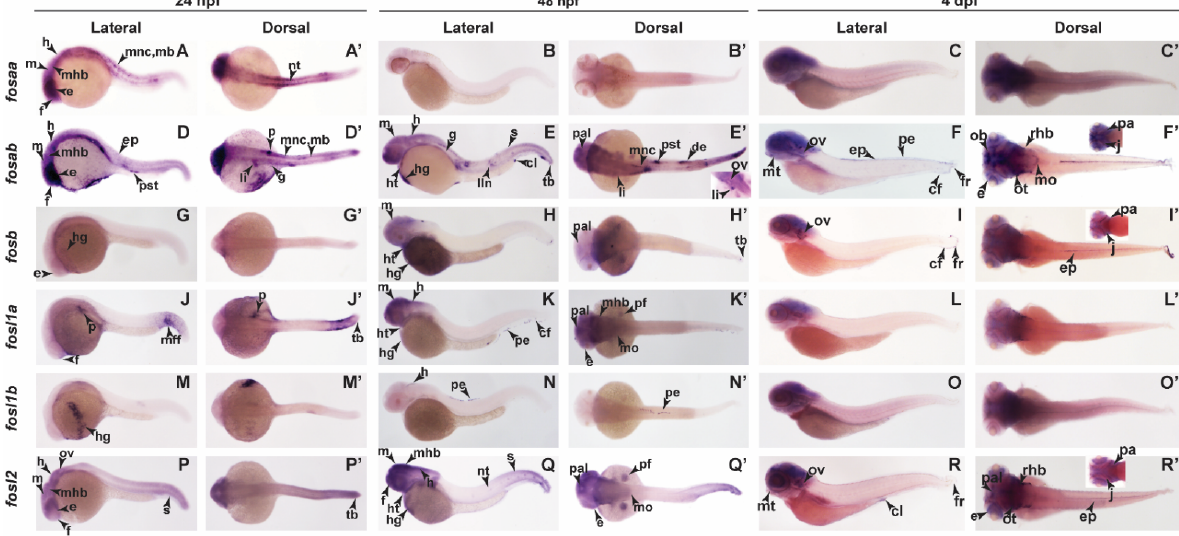
Figure 5. Spatiotemporal expression of fos genes in later stages of zebrafish embryonic development. Lateral and dorsal views of zebrafish embryos analysed by WISH showing expression for fosaa at 24 hpf ( A , A’ ) , 48 hpf ( B , B’ ), and 4 dpf ( C , C’ ); fosab at 24 hpf ( D , D’ ) , 48 hpf ( E , E’ ), and 4 dpf ( F , F’ ) ; fosb at 24 hpf ( G , G’ ) , 48 hpf ( H , H’ ), and 4 dpf ( I , I’ ); fosl1a at 24 hpf ( J , J’ ) , 48 hpf ( K , K’ ), and 4